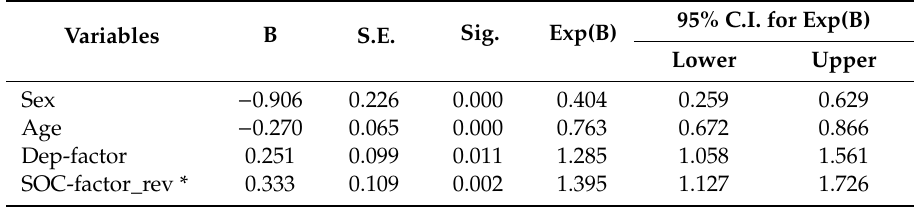
Table 6. Binary logistic regression analysis of the depression-factor and sense of coherence-factor to energy drink addiction, controlled for age and sex. 95% C.I. for Exp(B) Variables B S.E. Sig. Exp(B) Lower Upper Sex − 0.906 0.226 0.000 0.404 0.259 −